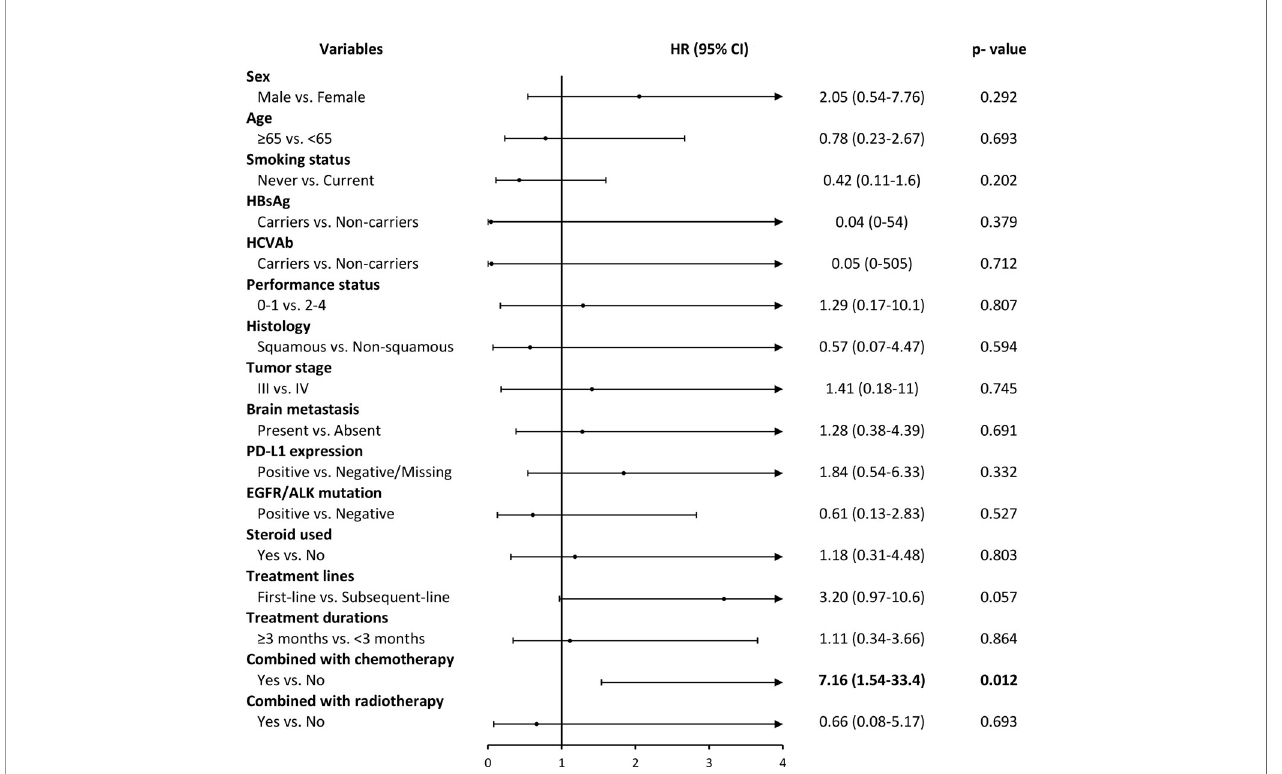
FIGURE 3 | ICIs drugs use and its association with grade 3 and over adverse events by different covariates. HR, hazard ratio; CI, con fi dence